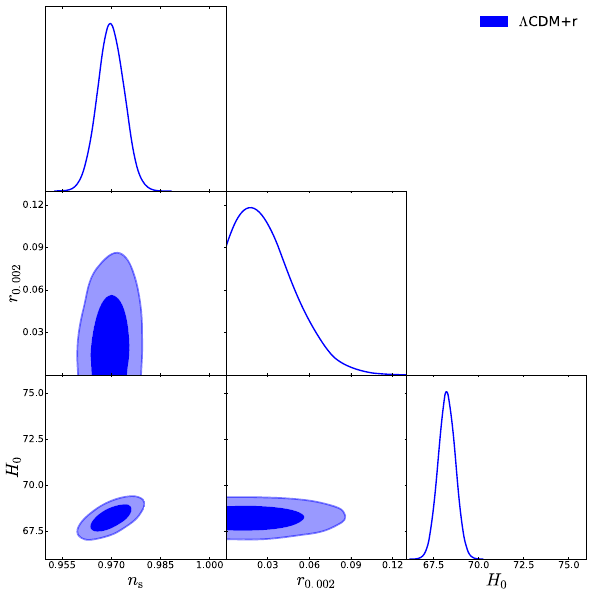
Fig. 1 One-dimensional marginalized distributions and two- dimensional contours (1 σ and 2 σ ) for parameters n s , r 0 . 002 and H 0 in the (cid:2) CDM + r model using the Planck + BK + BAO + H 0